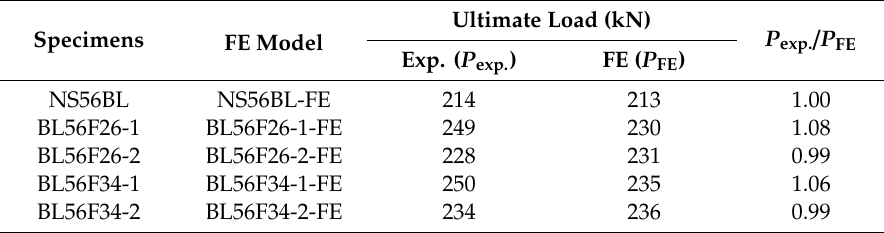
Table 2. Comparison between FE analysis and test